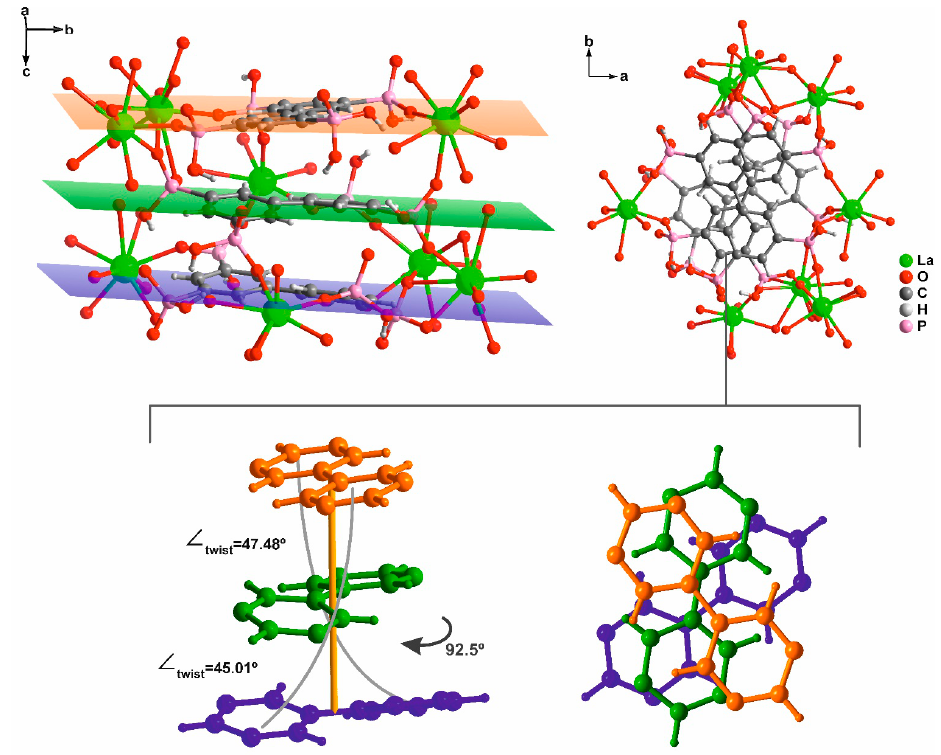
Figure 6. Schematic representation of the organic cylinder present in the crystal structure of [La 4 (H 5 btp)(H 4 btp)(H 3 btp)(H 2 O) 8 ] ∙ 3H 2 O ( 2La ). The schemes emphasize the close packing of the organic linkers, with inter-planar distances ranging between 3.5545(5) and 3.9692(5) Å. On the right there is a representation of the same organic skeleton in the cylinder emphasizing the close packing and rotation along the a -axis of the three aromatic cores.